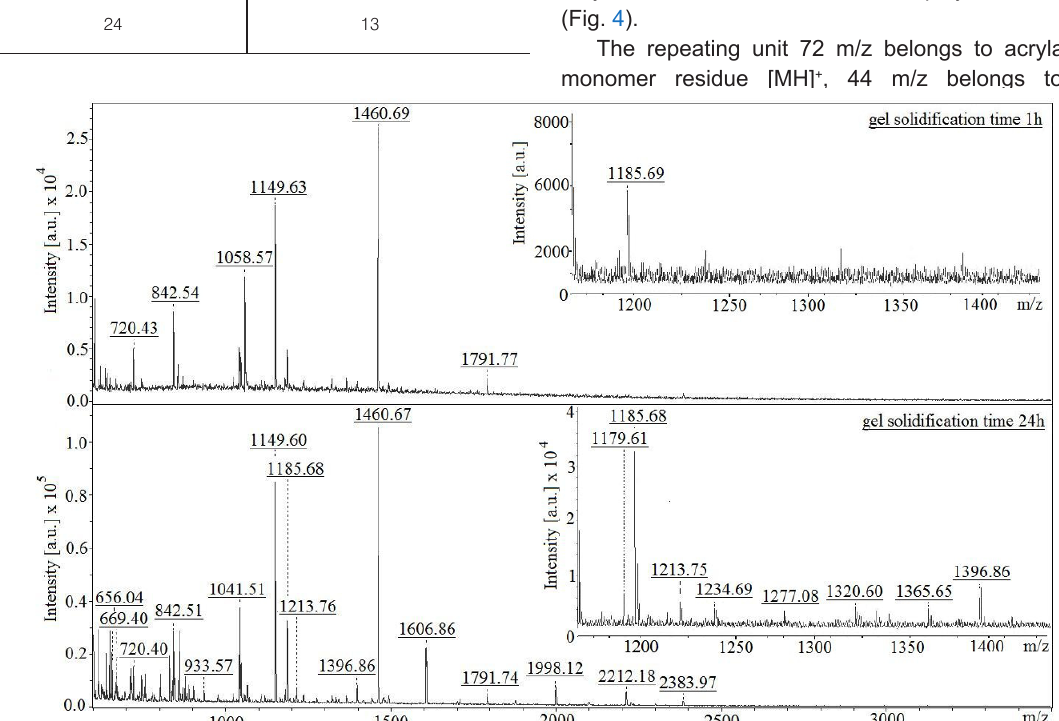
Figure 3. The comparison of prohibition PMF spectrum from the two gels with different solidification time (1 h and 24